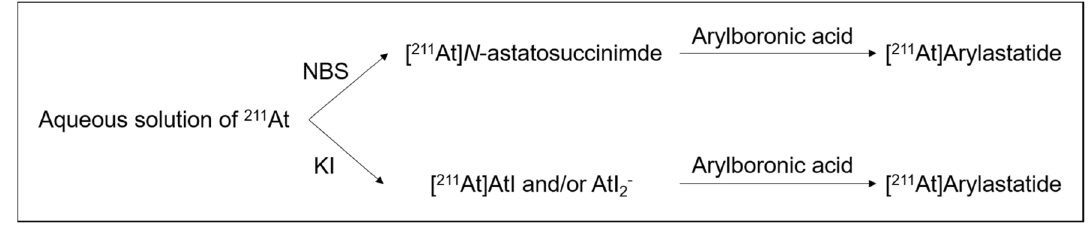
Figure 6. Astatination of arylboronic acids by NBS or KI via the corresponding